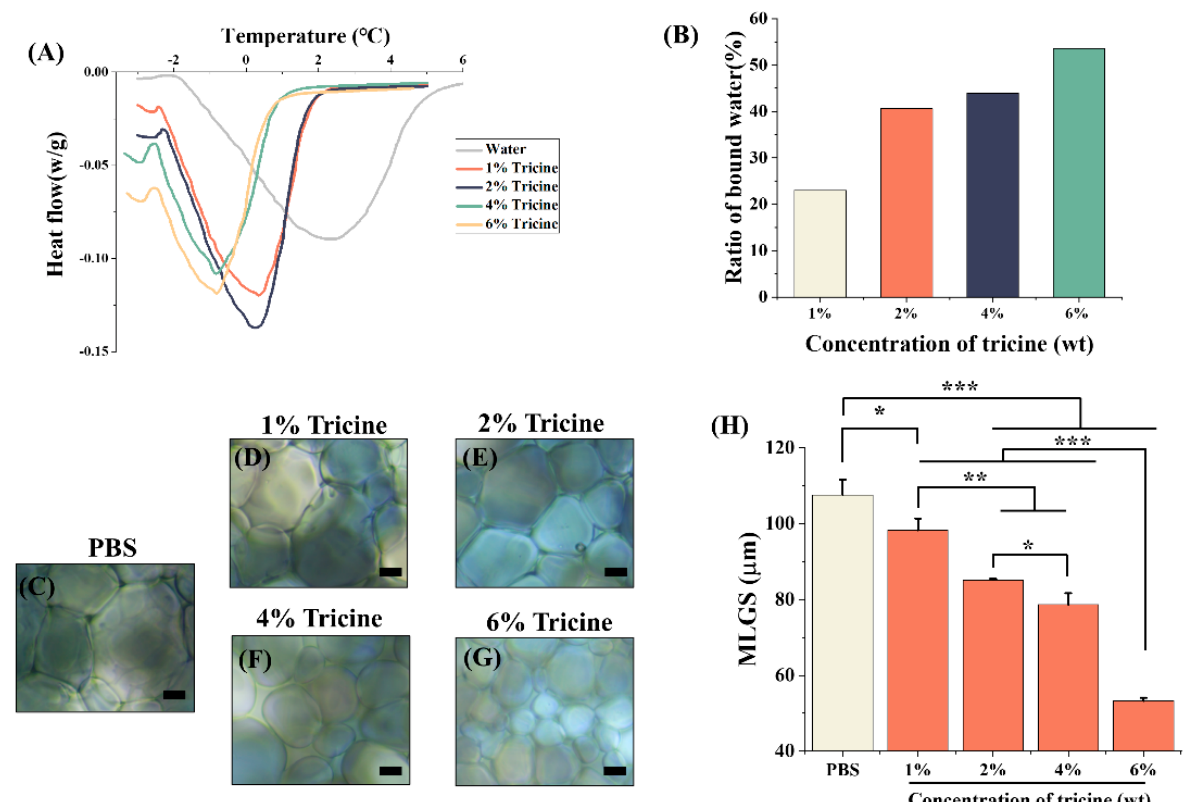
Figure 4. The ability to reduce the mechanical damage from ice. ( A ) The heat flow during the melting process. ( B ) The ratio of bound water in different concentrations of tricine. The representative im ‐ ages of ice crystals in ( C ) PBS, ( D ) 1% tricine, ( E ) 2% tricine, ( F ) 4% tricine and ( G ) 6% tricine. ( H ) Quantitative analysis of IRI activity through MLGS. MLGS = mean largest grain size. * p < 0.05; ** p < 0.01; *** p < 0.001. Scale bar = 20 μ m.